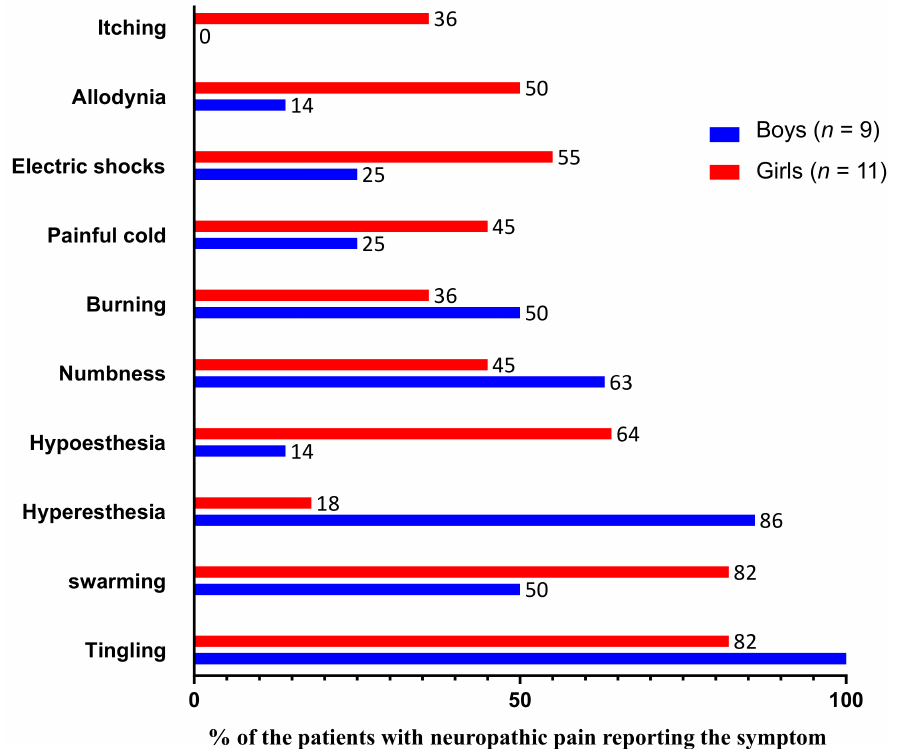
Figure 1. Characteristics of neuropathic symptoms depending on